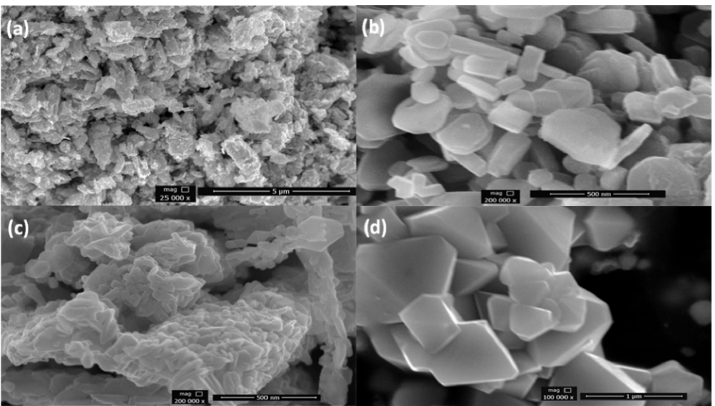
Figure 4. SEM results for the samples. ( a ) CP1 calcined at 700 °C after leaching, ( b ) CP2 calcined at 800 °C after leaching, ( c ) CP3 calcined at 600 °C after leaching, and ( d ) CP4 unprocessed waste cathode material calcined at 600 °C.